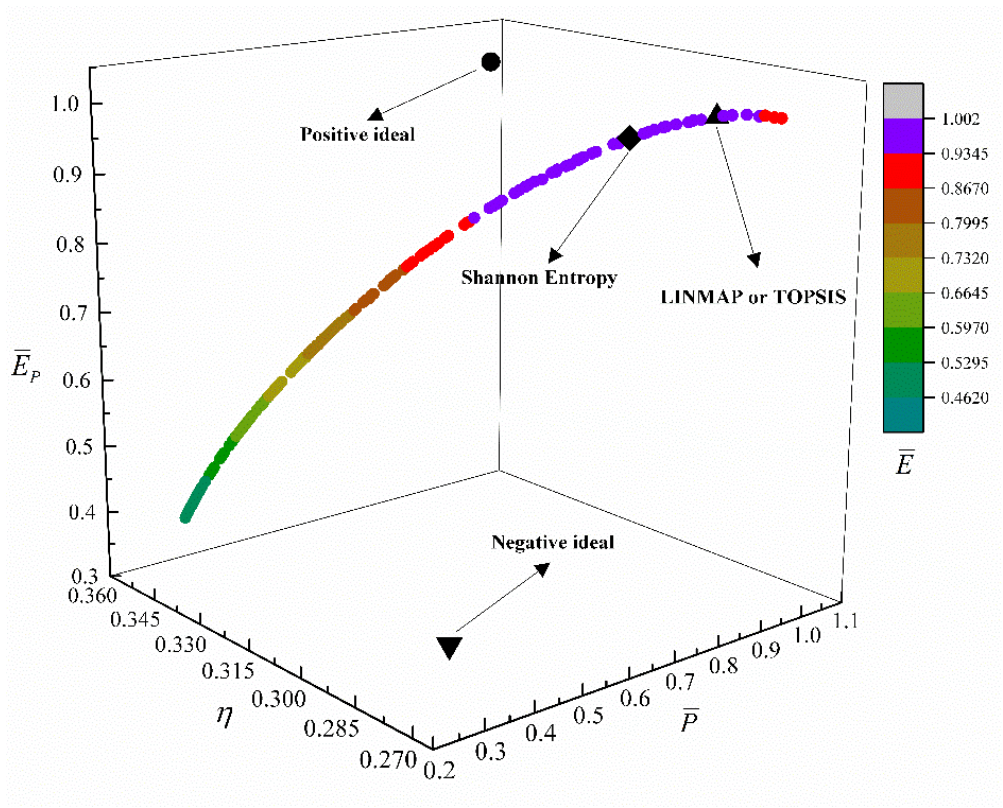
Figure 3. Pareto frontier with